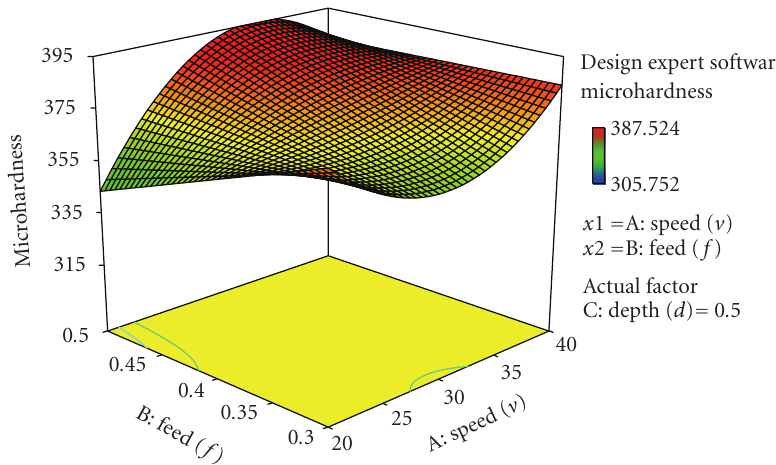
Figure 6.6 . 3D graph of microhardness as a function of speed and feed at higher depth of cut ( d =